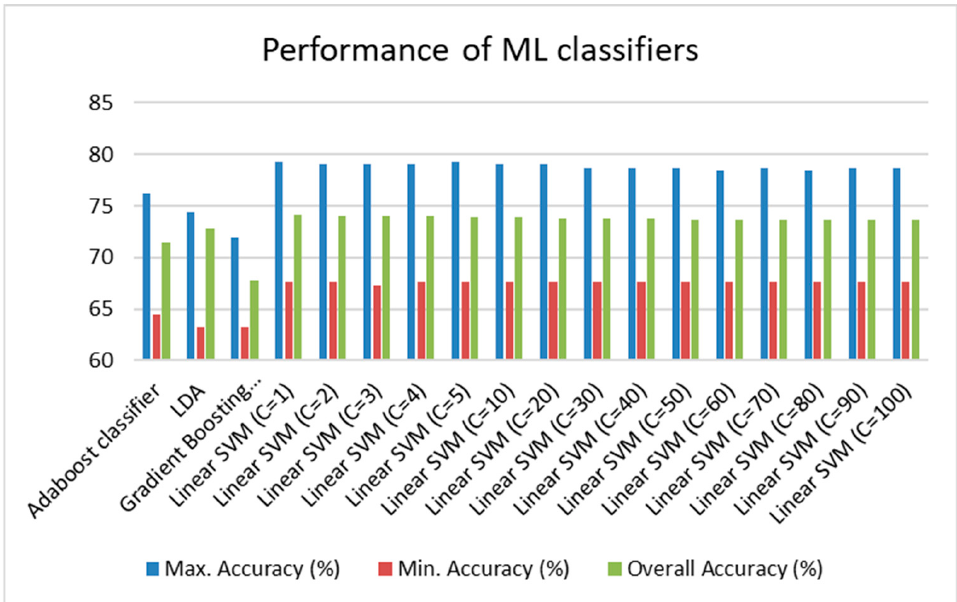
Figure 7. Maximum, minimum and overall testing accuracy of the ML classifiers.